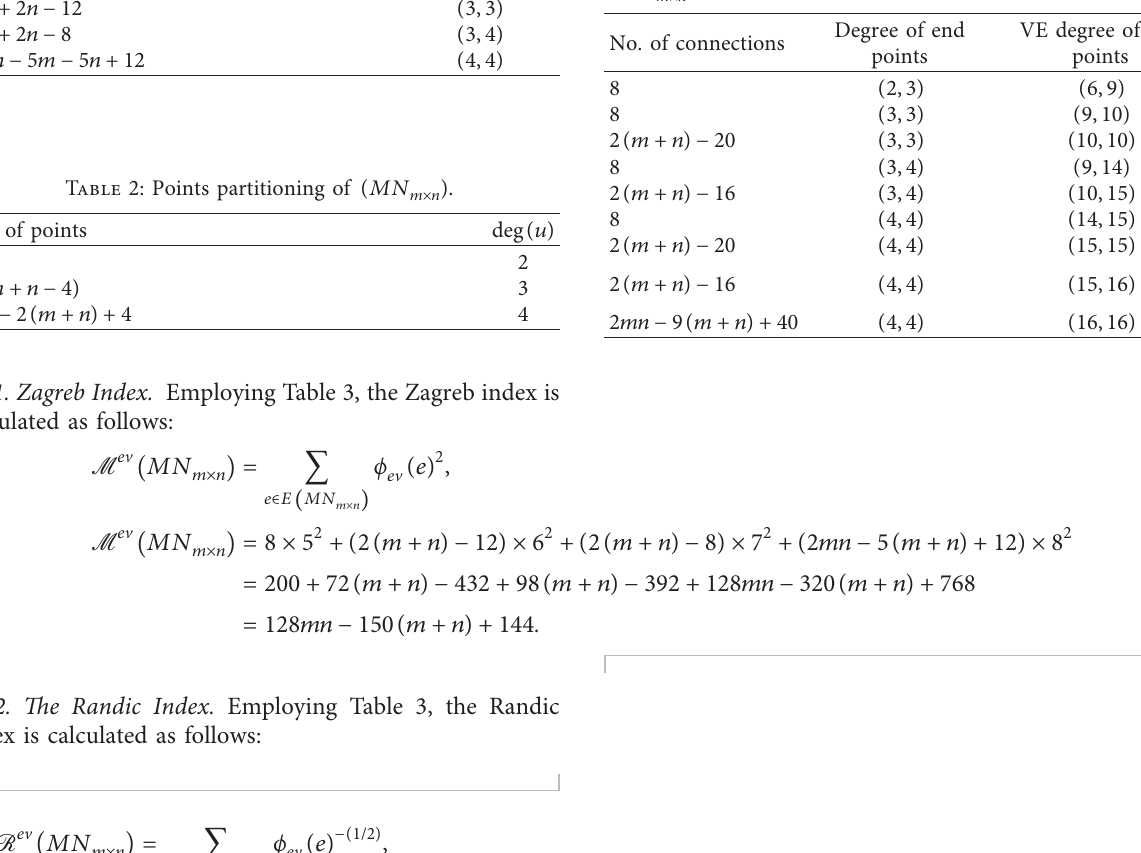
Table 1: Connection division of ( MN